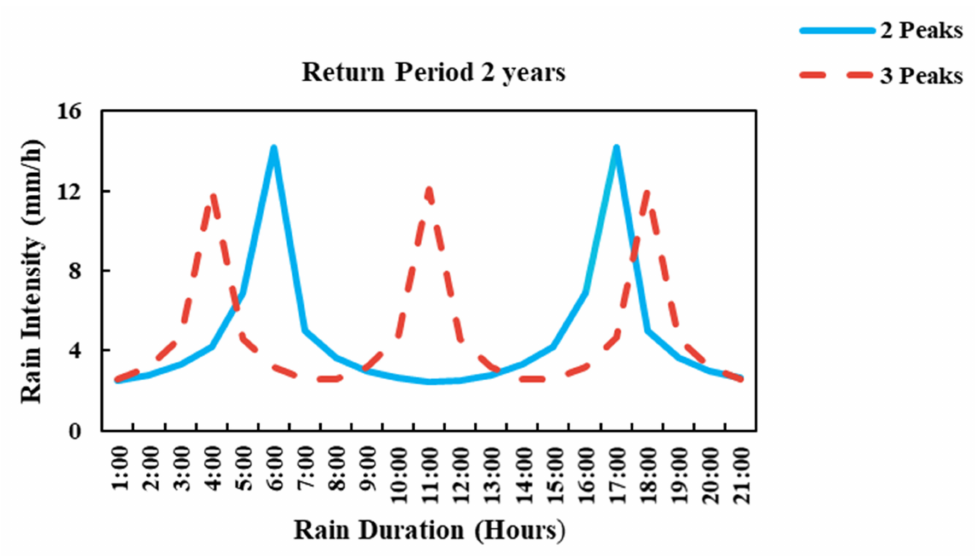
Figure 6. Multi-peak Chicago design storm by different peak